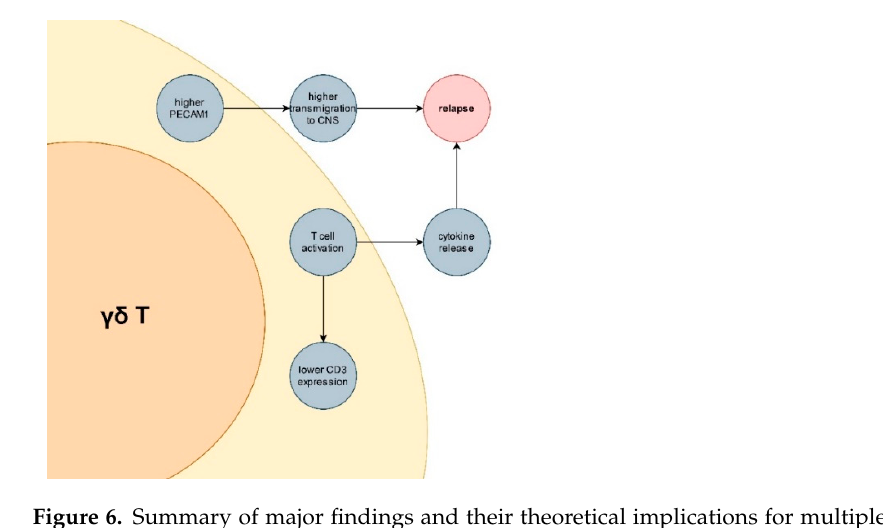
Table S2: Spearman correlation matrix for major clinical and immunological